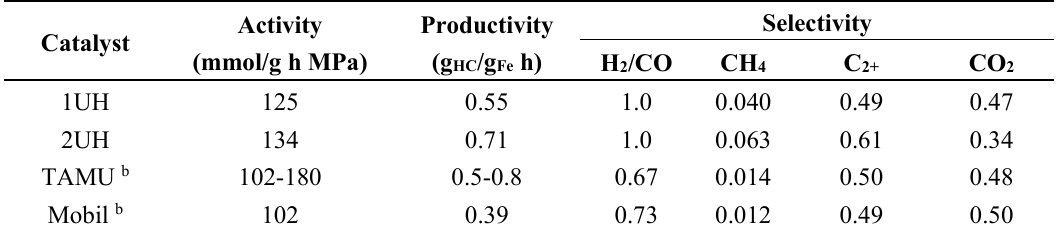
Table 4. Comparison of 1UH and 2UH with published, highly active iron catalysts a